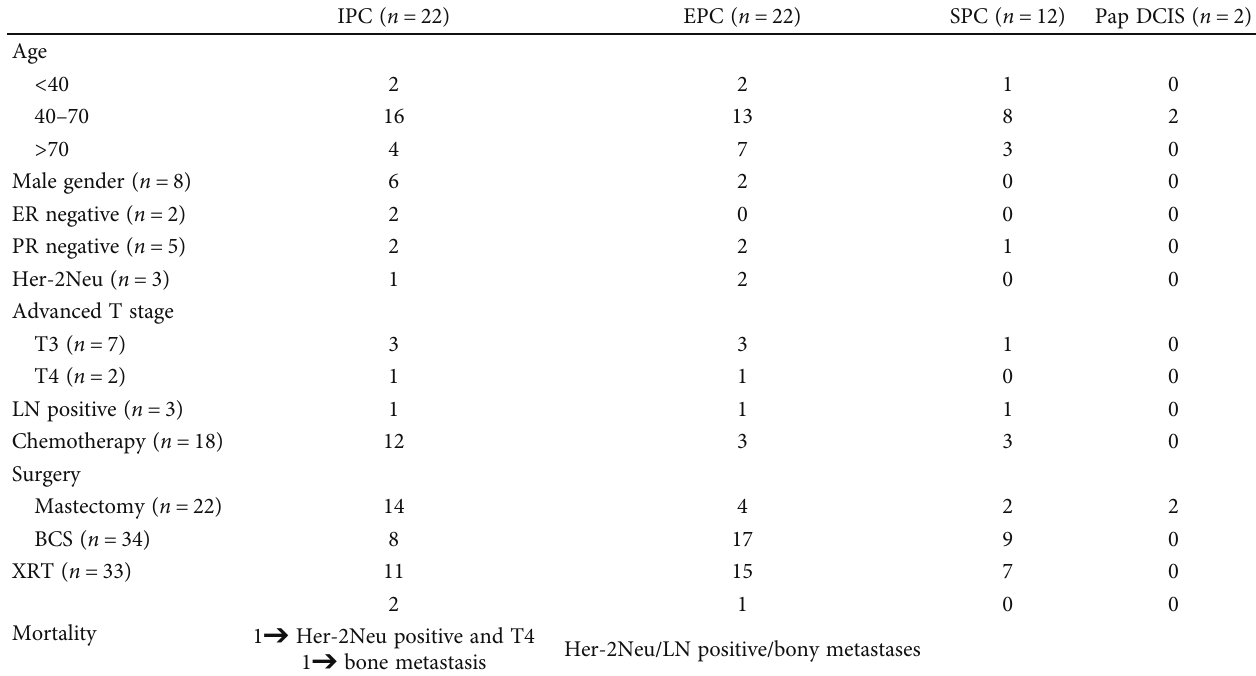
Table 5: Various characteristics among 4 tumor types